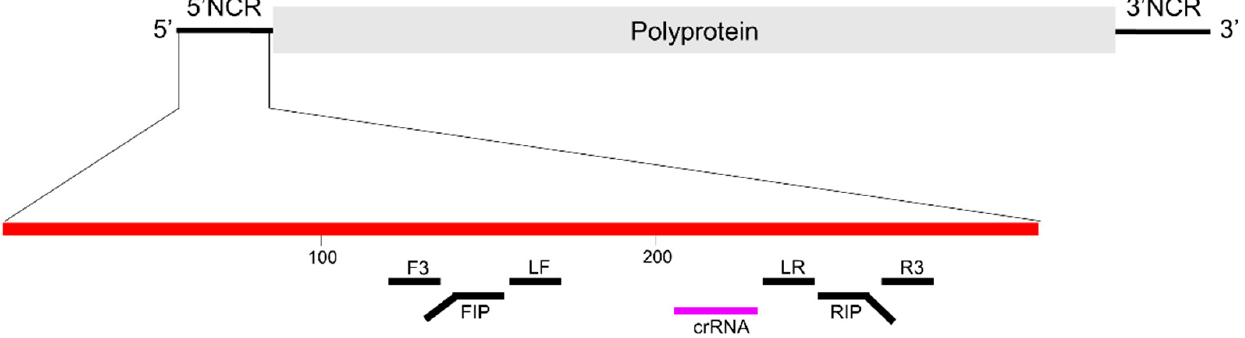
Figure 2. Genome map with the binding positions of RT-LAMP primers and crRNA. Red line indicates the 5 ′ NCR of HCV genome, the black lines indicate the LAMP primers, and the purple line represents the crRNA. NCR, noncoding region; F3, forward outer primer; R3, reverse outer primer; FIP, forward inner primer; RIP, reverse inner primer; LF, loop forward primer; LR, loop reverse primer; crRNA, CRISPR RNA.